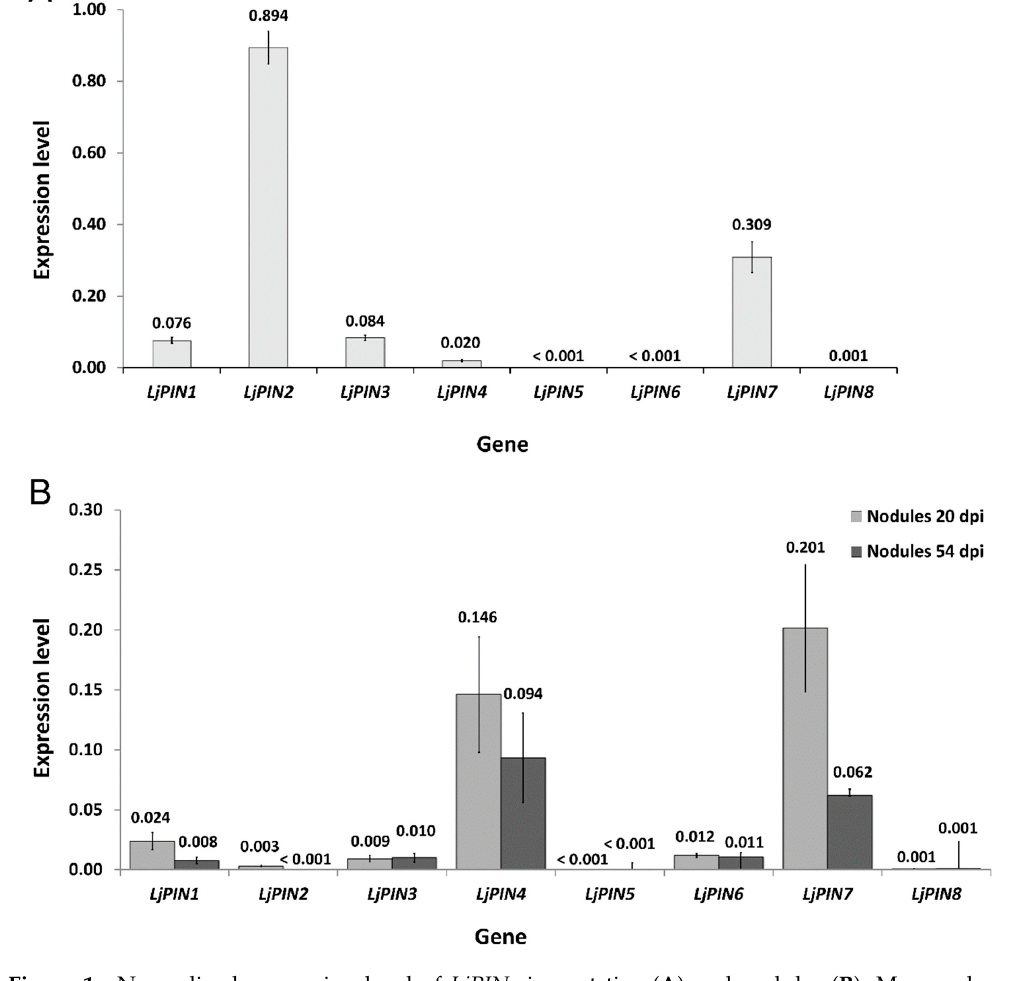
Figure 1. Normalized expression level of LjPINs in root tips ( A ) and nodules ( B ). Mean values (±standard error (SE)) are derived from three biological replicates, for which three individual quantitative polymerase chain reactions (qPCR) were performed ( n = 9).